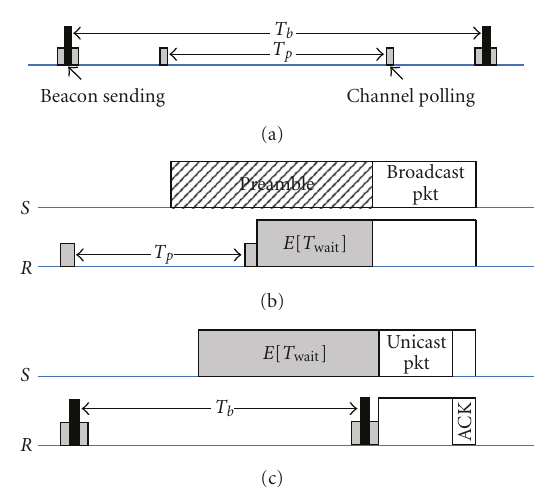
Figure 2: Dual wake-up low power listening (DW-LPL): (a) channel polling and beacon sending wake-ups; (b) transmitter- initiated transmission mode; (c) receiver-initiated transmission